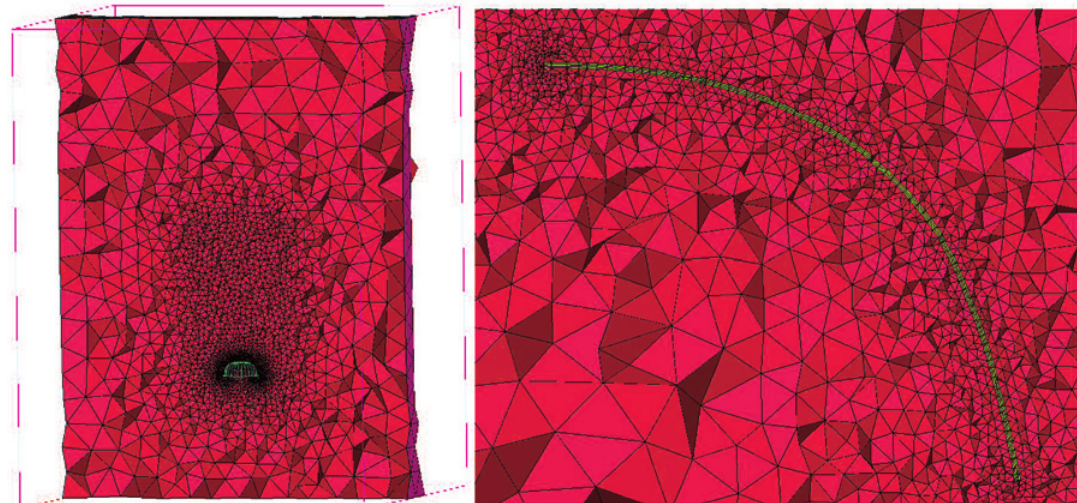
Fig. 12. Fluid domain and porous media doma in (left: t he whole; right: the enlarged)